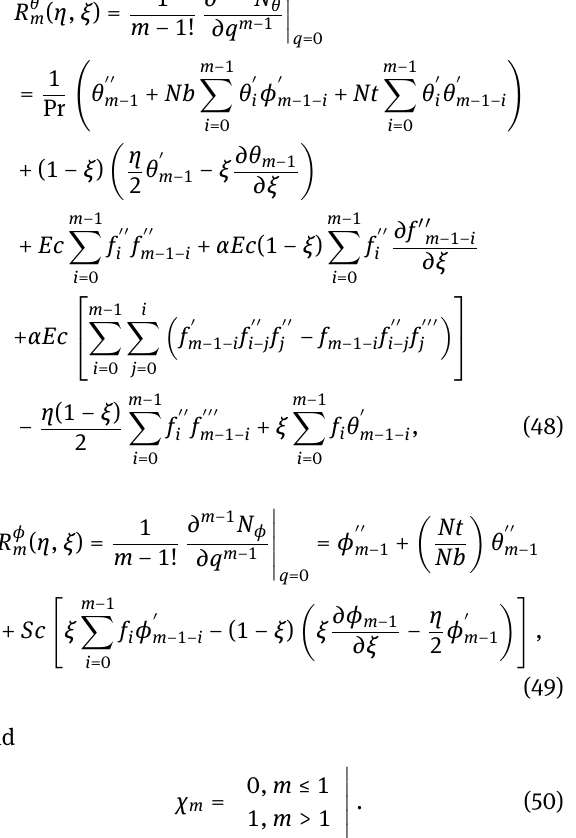
Table 1: The values of f (cid:48) (0, ξ ) , θ (0, ξ ) and ϕ (cid:48) (0, ξ ) for different order of approximations for the values of parameters Nt = Nb =